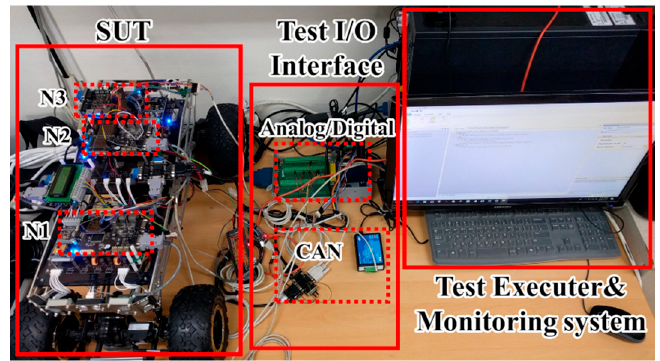
Figure 9. HiL test environment.